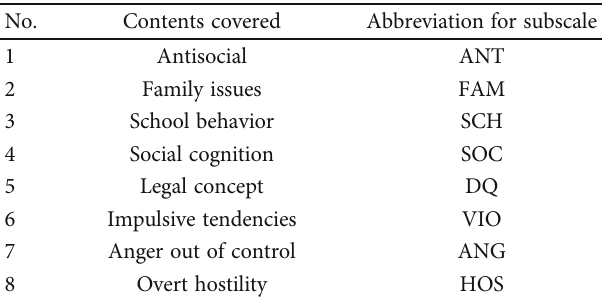
Table 1: The contents of